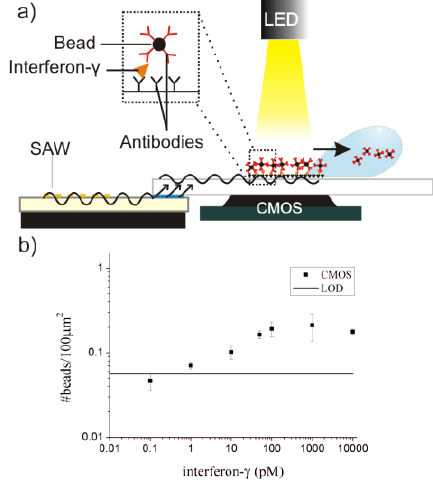
FIGURE 2: a) Schematic of the platform b) Dose-response curve of the immunoassay for interferon-  .